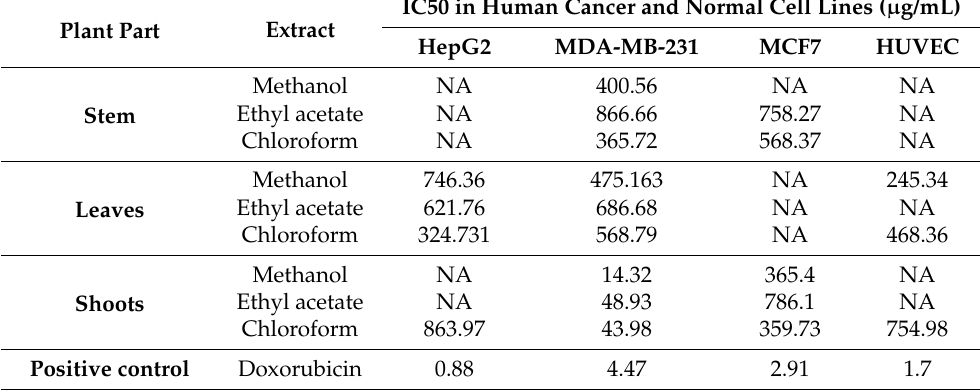
Table 1. The effect of crude extract of plant parts of M. sinaica on cell survival of human cancer and normal cell lines.